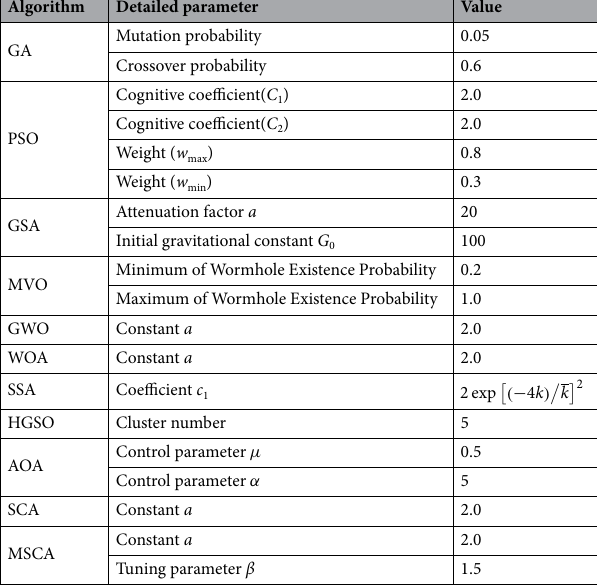
Table 2. The default parameters of selected